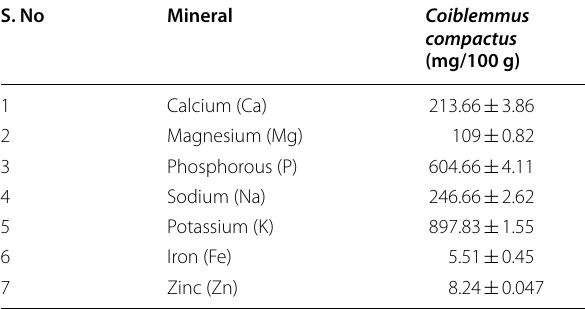
Table 3 Mineral composition of Coiblemmus compactus